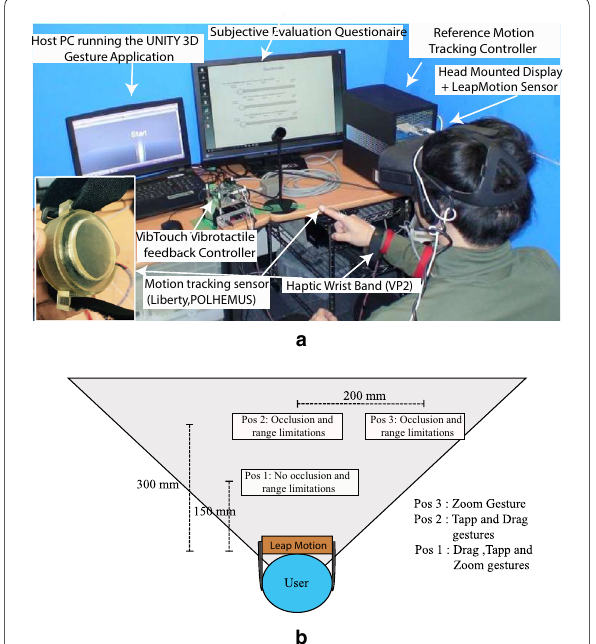
Fig. 4 Experimental set up. Experimental set up, and location of gesture executions. a The depth camera and the reference motion capture is shown here. The vibrotactile feedback is fed back to the user using a wristband. b The positions of stable and unstable tracking along with the distances to the depth camera attached to the HMD is shown